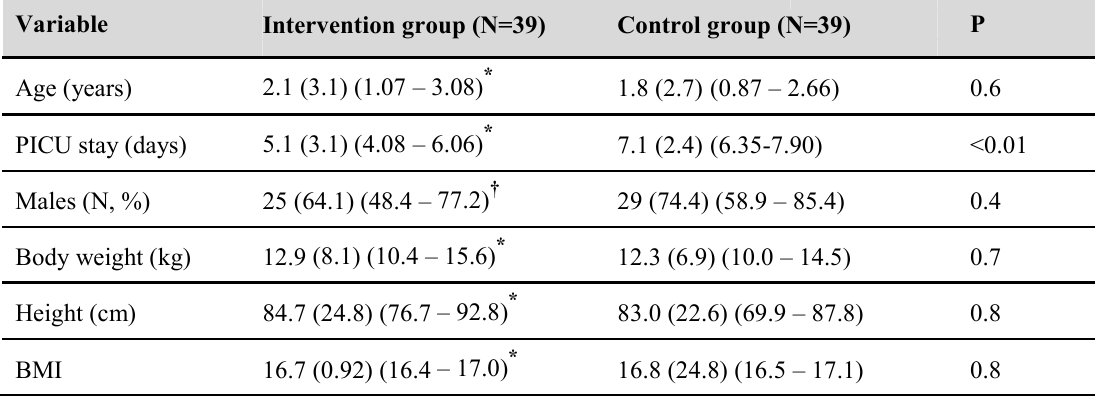
Table 1. Baseline characteristics in the ITT